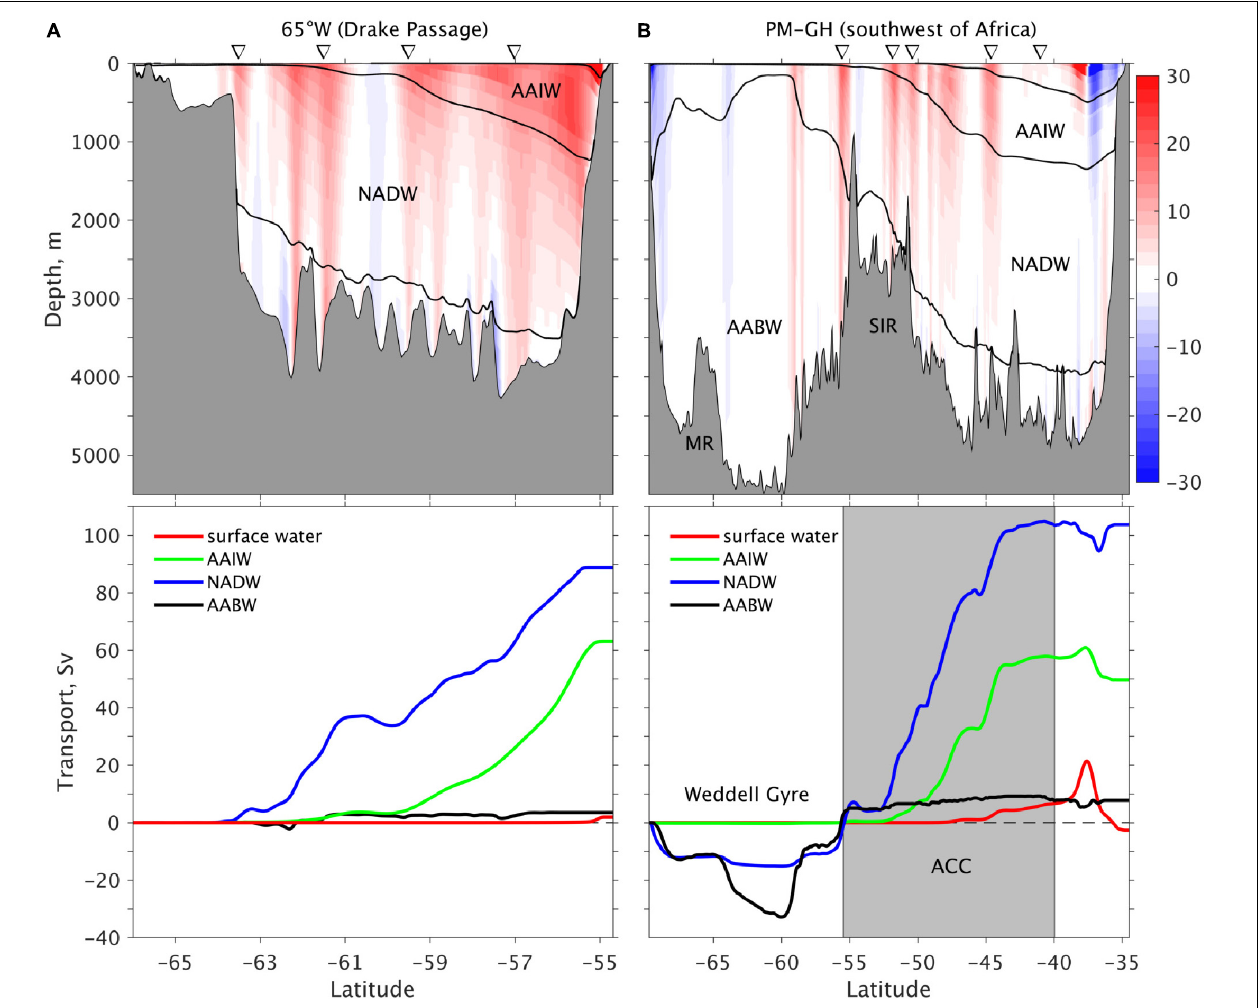
FIGURE 7 | Modeled long-term mean zonal velocity and the corresponding four-layer volume transport in four density layers across (A) 65 ◦ W in the Drake Passage and (B) the Prime Meridian-Good Hope (PM-GH) transect southwest of Africa. The triangles denote the locations of Antarctic circumpolar current (ACC) fronts, from south to north, the Southern Boundary, South ACC Front, Polar Front, Subantarctic Front, and the subtropical front in panel (B) . The shaded area in panel (B) between 40 and 55.5 ◦ S marks the ACC regime across the PM-GH transect. Transport is accumulative northward. The four layers are near surface water ( σ 2 < 35.65 kg m − 3 ), Antarctic Intermediate Water (AAIW, 35.65 < σ 2 < 36.58), North Atlantic Deep Water (NADW, 36.58 < σ 2 < 37.12), and Antarctic Bottom Water (AABW, σ 2 >